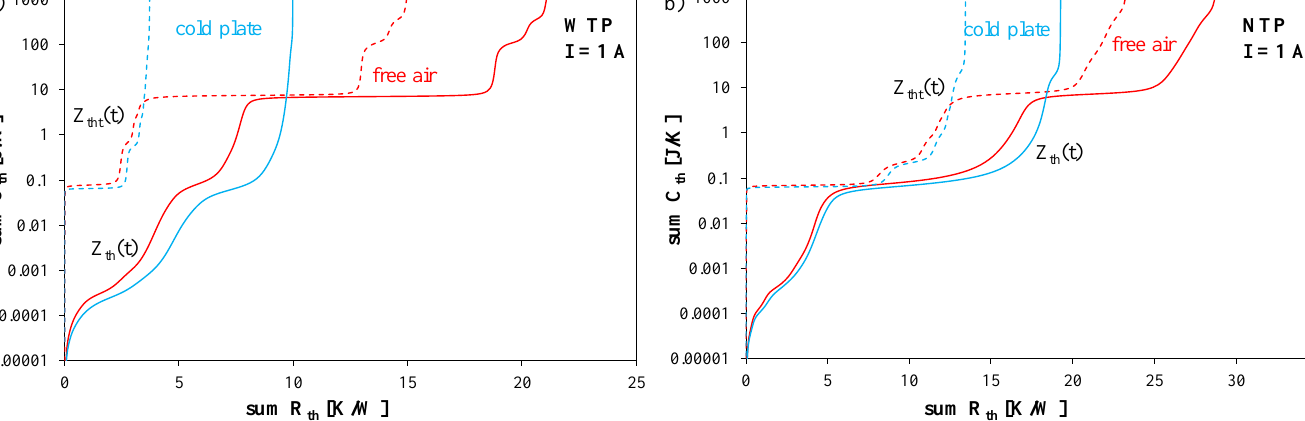
Figure 11. Structure functions determined using the MASTER program on the basis of the measured waveforms of self (solid lines) and transfer (dashed lines) transient thermal impedances of the diodes contained in the MCE device WTP ( a ) and NTP ( b ) measured with the T3Ster set-up. Figure 12 shows the discrete spectrum of thermal time constants of the compact ther- mal model of the MCE diode obtained with the ESTYM program for the measurement results Z th (t) and Z tht (t) shown in Figure 9. As can be seen, both mounting methods (WTP or NTP) and the cooling conditions (free convection air cooling or cold plate) of the tested diode significantly affected the obtained spectrum of thermal time constants. The larger number of thermal time constants describes the Z th (t) waveforms, which is related to the effect of heat transfer between the semiconductor structures and the housing on Z th (t). In the case of Z tht (t) these shortest thermal time constants are not visible. For the diodes mounted on a cold plate, the longest values did not exceed 10 s. On the other hand, for a